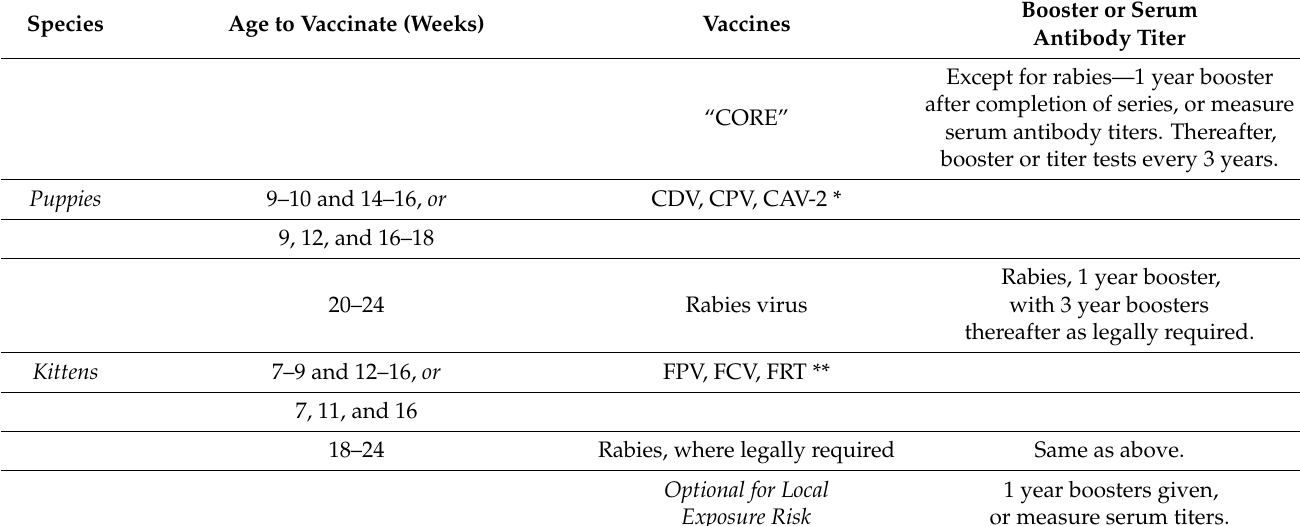
Table 1. Author’s Vaccine